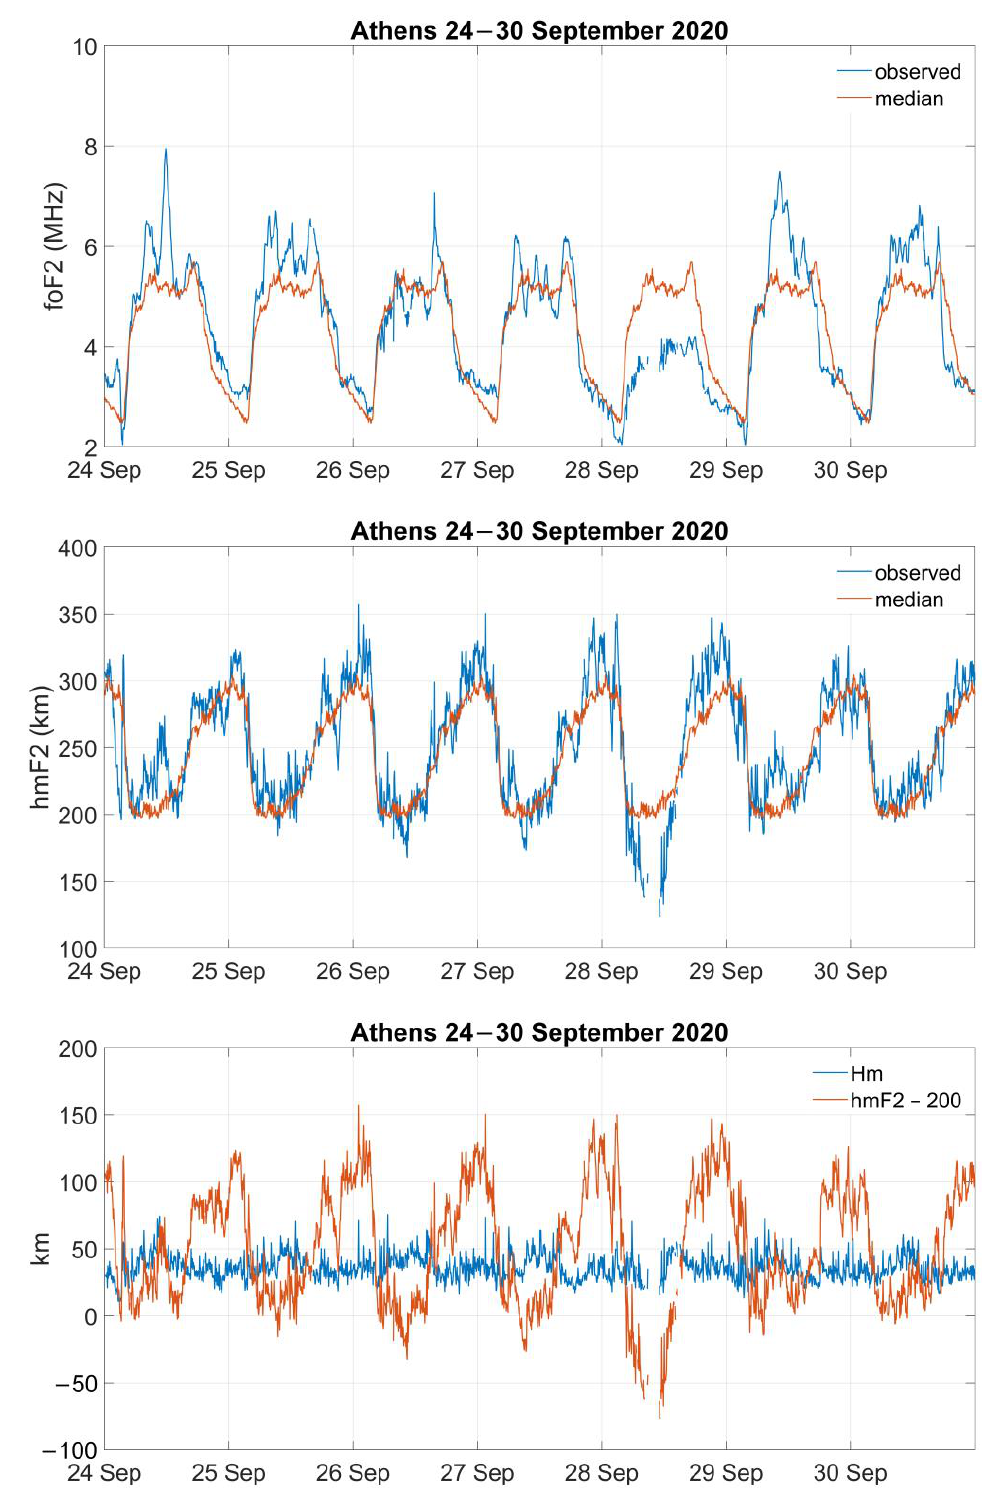
Figure 1. The variation of the Dst index ( top panel ) and the ionospheric characteristics extracted from Athens Digisonde manually scaled ionograms from 24 to 30 September 2020. Second to fourth panels show: the observed (blue line) and monthly medians (orange line) of the critical frequency foF2 ( second panel ), the true height of the peak electron density, hmF2 ( third panel ) and the scale height (Hm) together with the variation of (hmF2-200) ( fourth panel ).